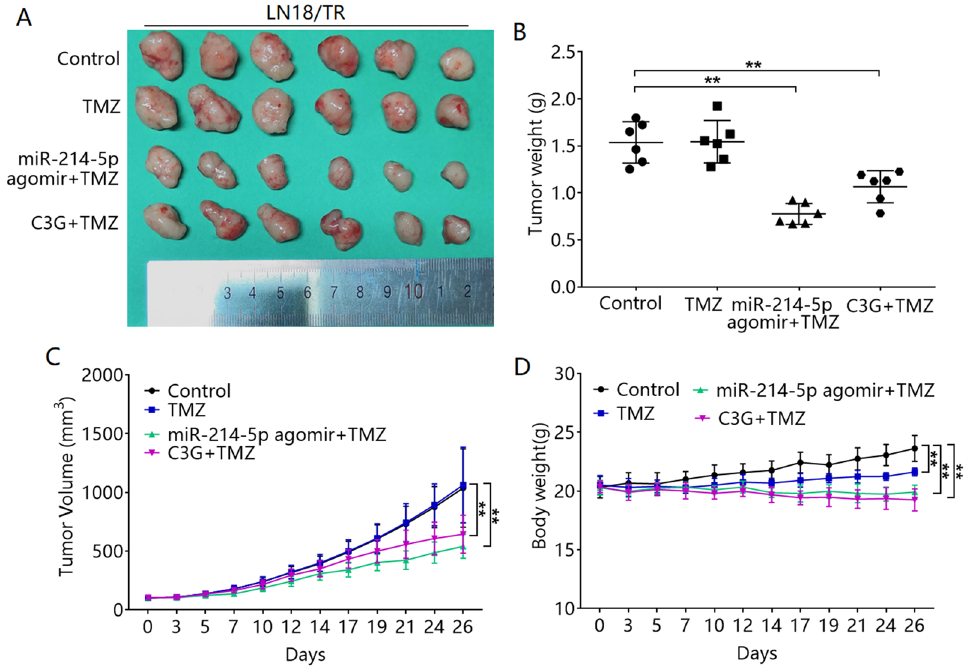
Figure 8. Cyanidin-3- O -glucoside (C3G) and miR-214-5p promote temozolomide (TMZ) sensitivity in vivo. ( A ) Representative images of control, TMZ, C3G + TMZ, miR-214-5p agomir + TMZ group tumors. ( B ) Tumor weights of each group of animals. ** P < 0.01. ( C ) The tumor volume changes in each group of animals. Compared with control, ** P < 0.01. ( D ) Changes in body weights of animals in each group. Compared with control, ** P < 0.01. Compared with TMZ, ## P <